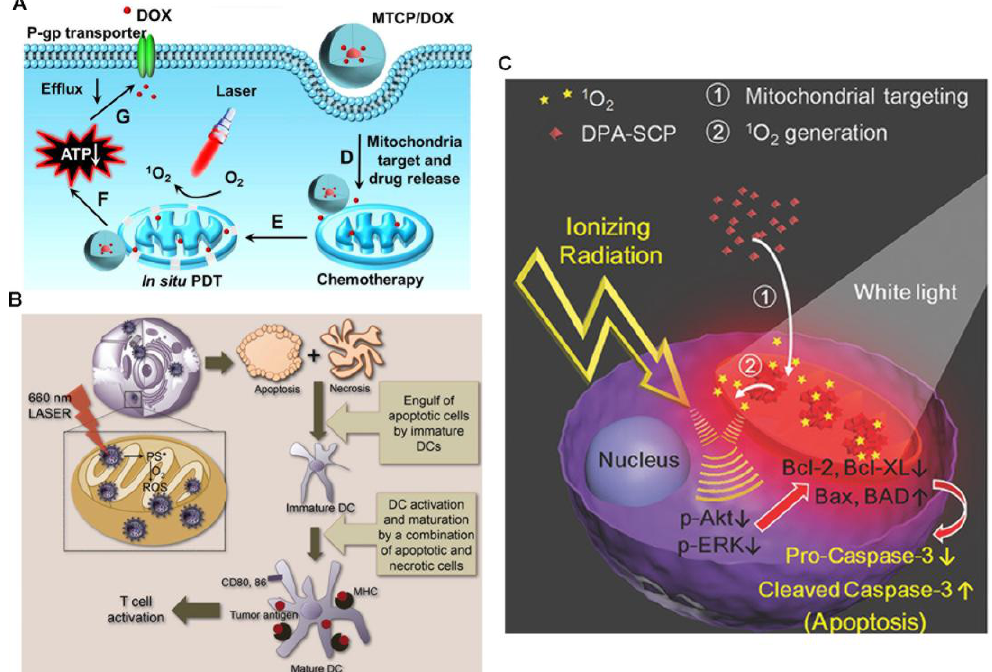
Figure 5. The combination of mitochondria-oriented PT with chemotherapy ( A ), reprinted with permission from Ref. [95]. Copyright 2016 American Chemical Society. The combination of mitochondria-oriented PT with immunotherapy ( B ), reproduced with permission from the Ref. [78]. Copyright 2013 American Chemical Society. The combination of mitochondria-oriented PT with radiotherapy ( C ), reprinted with permission from Ref. [41]. Copyright 2017 Wiley.